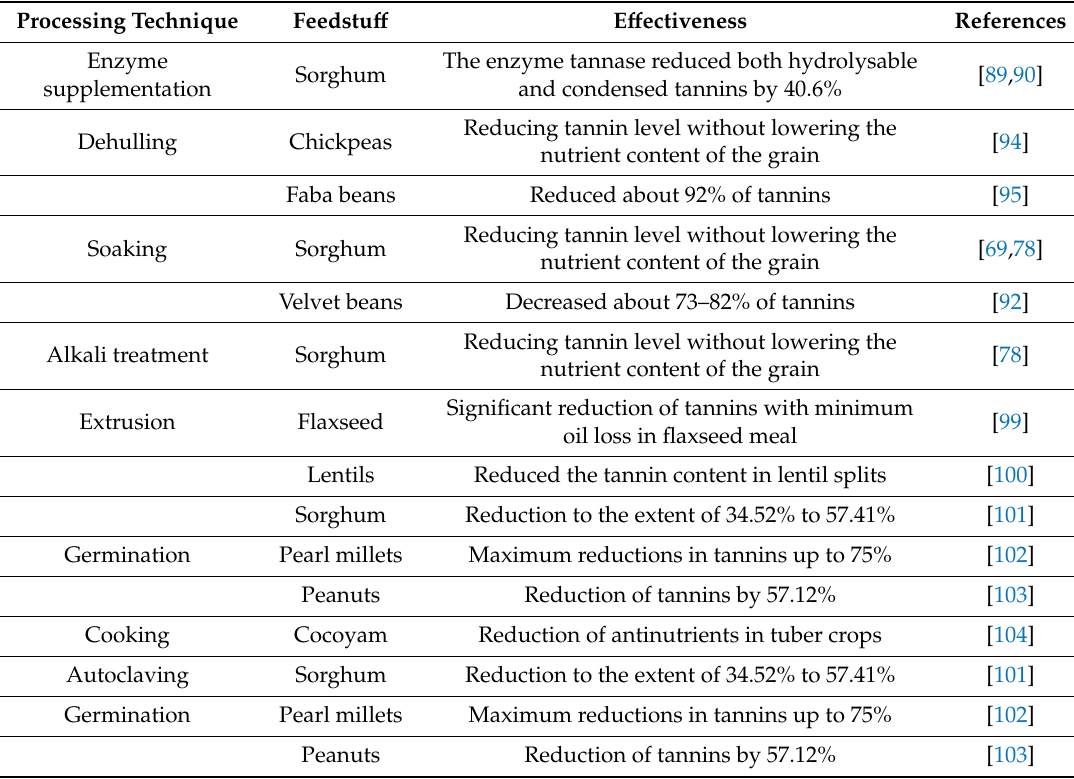
Table 5. Di ff erent processing techniques used to reduce the e ff ects of tannins in alternative feedstu ff s. Processing